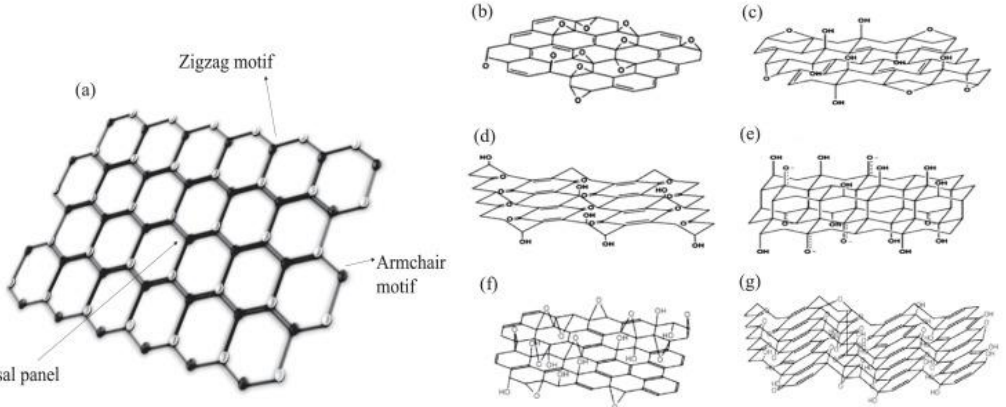
Figure 3. Structures of pristine graphene ( a ) and its GO derivatives based on Hofmann ( b ), Ruess ( c ), Scholz–Boehm ( d ), Nakajima–Matsuo ( e ), Lerf–Klinowski ( f ) and Szabo ( g ) models. Reproduced, adapted and reprinted with permission from Reference [47] .